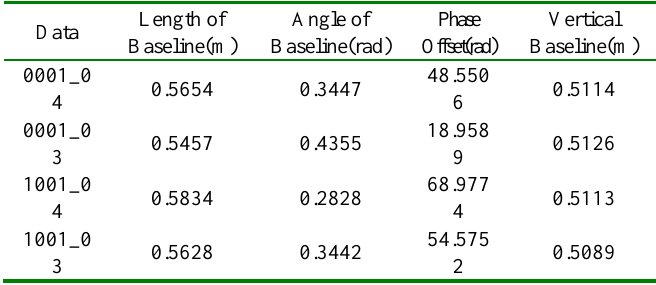
Tab. 4 Estimated Parameters with Block